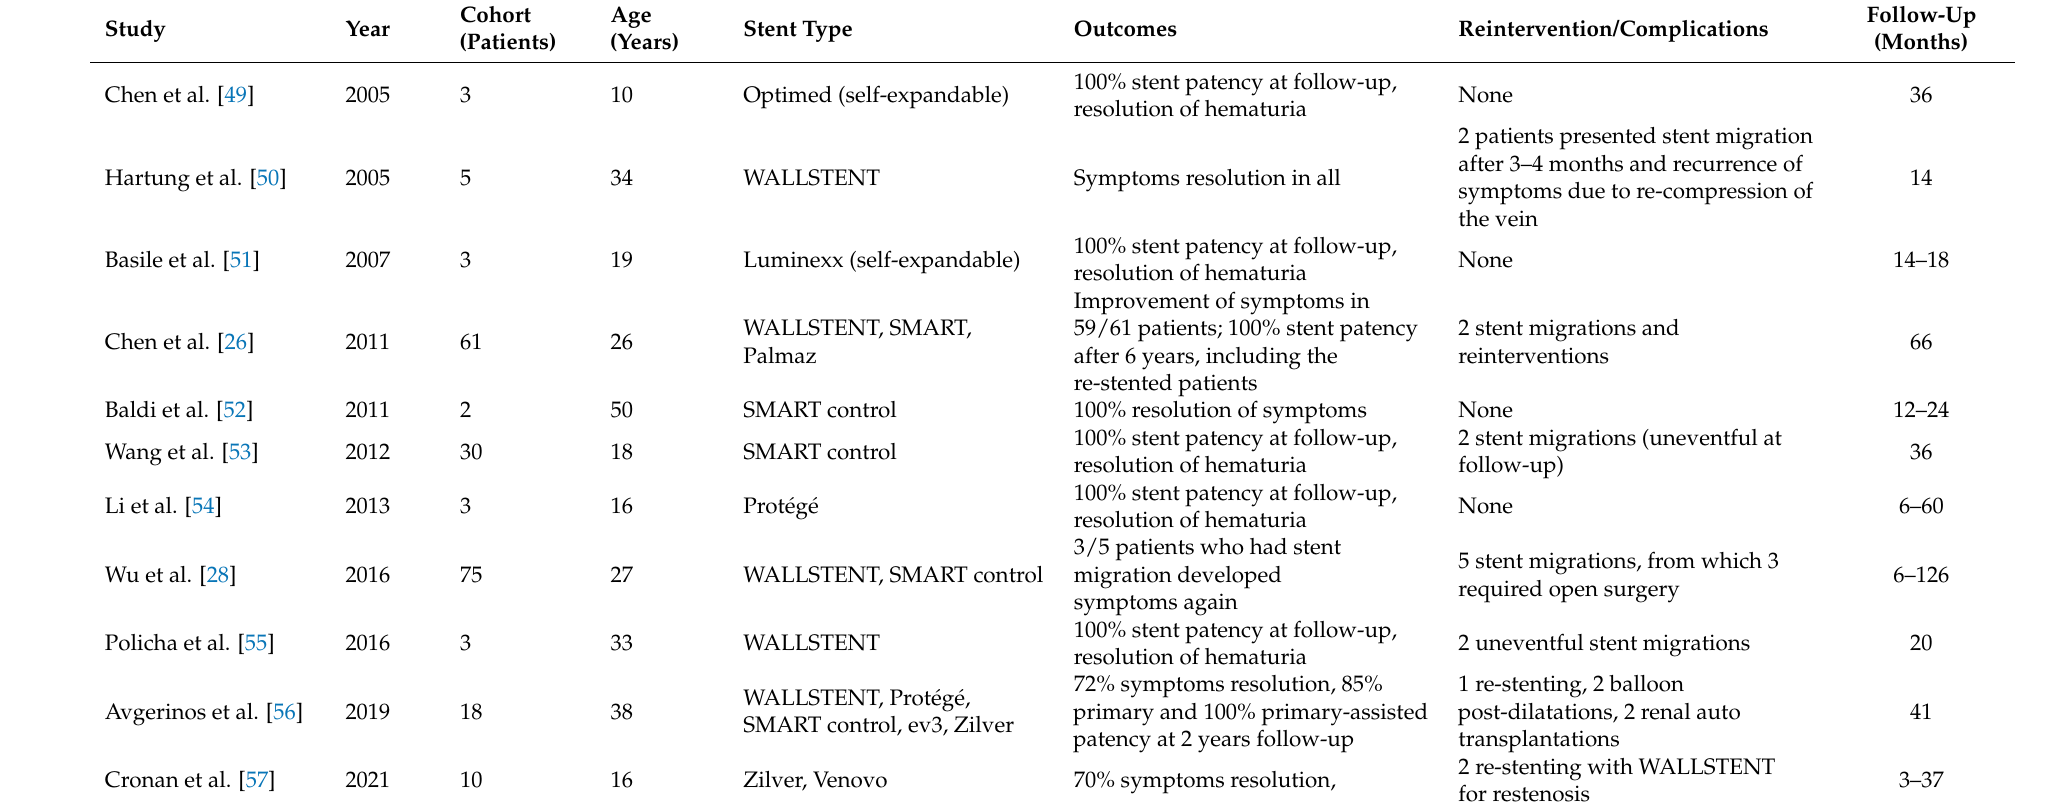
Table 1. Studies of left renal vein stenting for patients with nutcracker syndrome; age and follow-up are mean